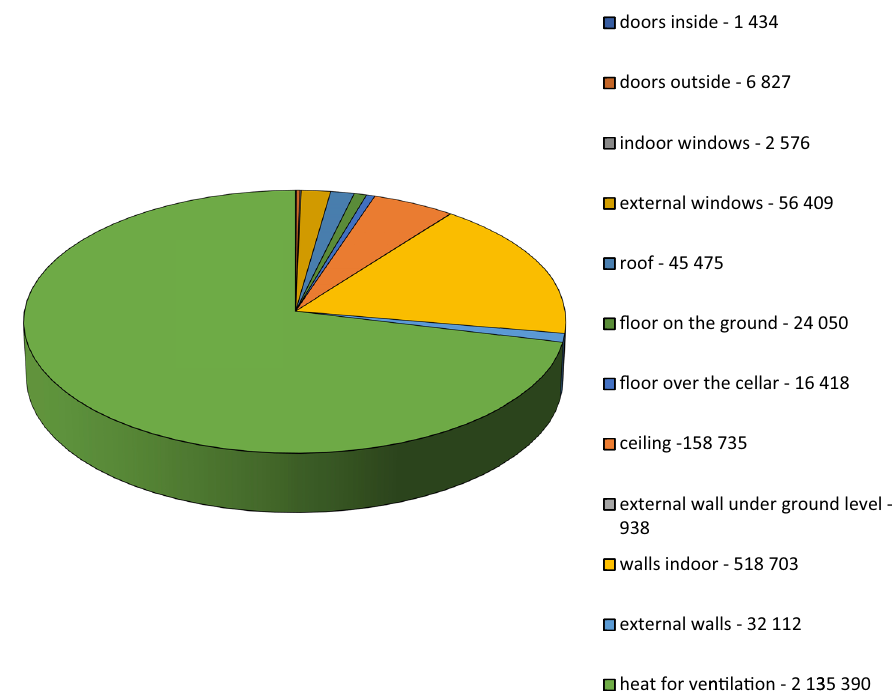
Figure 2: Space heating - energy losses ( source: based on an earlier study [ 56 ])